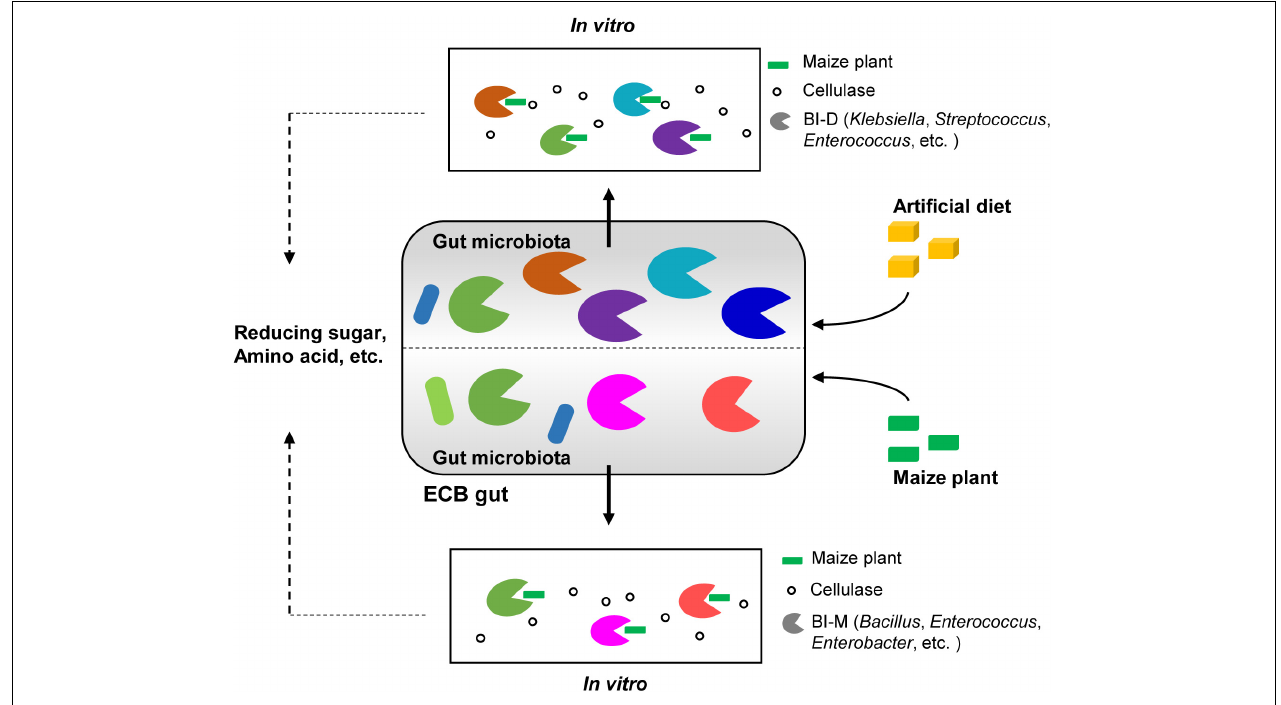
FIGURE 6 | Graphical summary of the main results. Diet shapes the gut bacterial community of ECB larvae. Two bacterial isolates from the guts of ECB larvae exhibited the ability to degrade maize cellulose to varying degrees in vitro and produced distinctive metabolomic profiles, including reduced sugars and amino